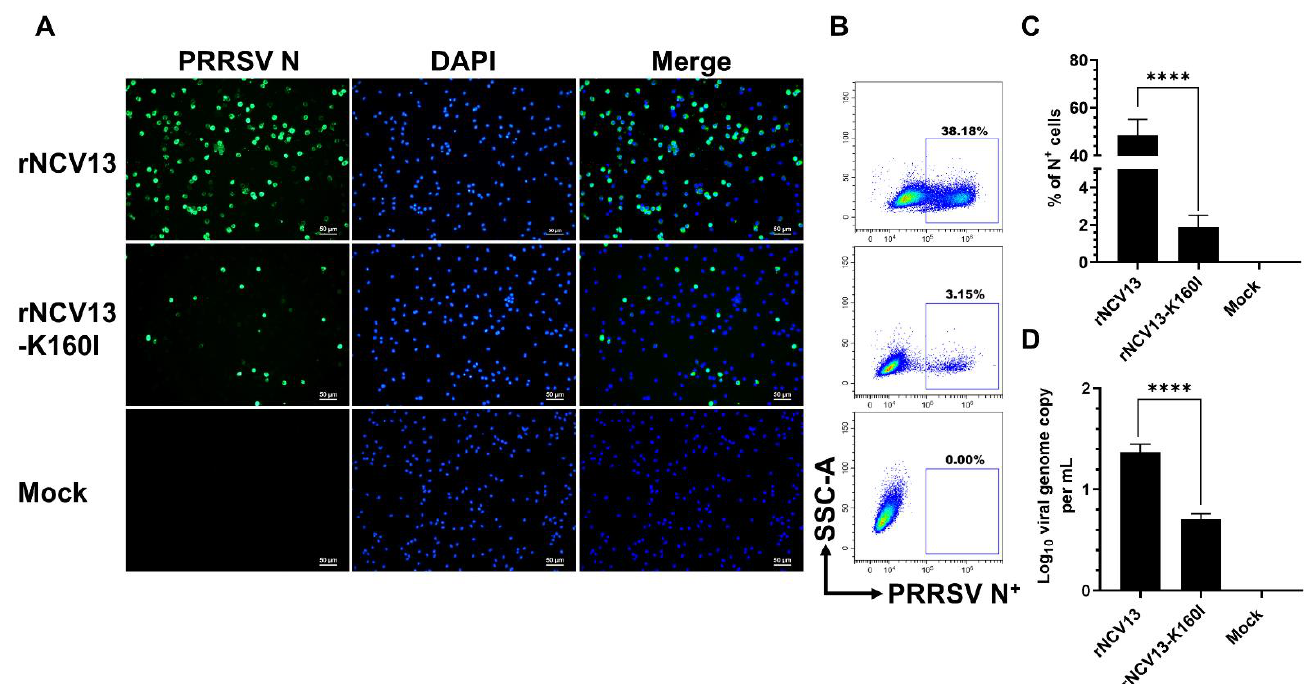
Figure 8. Infectivity of the low passage rNCV13 strain and its derived mutant in PAMs. PAMs collected from four piglets were inoculated with the indicated viruses at an MOI of 0.1. All data were collected at 12 hpi. ( A ) Representative images of cells that were fixed and stained with an anti-N antibody to visualize virus-infected cells (green color). DAPI was used to stain the nuclei (blue color). Scale bar = 50 μm. ( B ) Representative flowcytometry plots of PAMs that were fixed and stained with an FITC-labeled anti-N antibody. Uninfected cells were used to set-up gating. ( C ) Percentage of PAMs expressing N protein as quantified by flowcytometry. ( D ) Difference of viral genome copy numbers in the culture supernatants collected at 0 hpi and 12 hpi as quantified by RT-qPCR. Data are presented as means and SEM of the three independent experiments each of which involved four populations of PAMs collected from four different pigs. **** p < 0.0001.